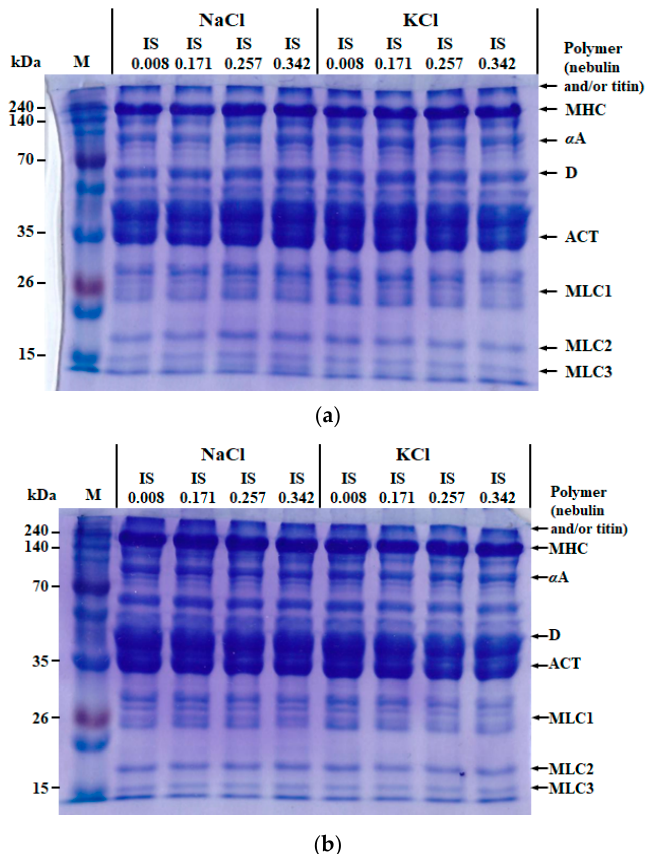
Figure 3. Representative sodium dodecyl sulfate poly-acrylamide gel electrophoresis (SDS-PAGE) photos of colloid Coomassie blue-stained 12.5% polyacrylamide gels of pre- ( a ) and post-rigor ( b ) salted chicken breast with NaCl or KCl at different ionic strengths. IS, ionic strength; M, standard protein marker; polymer, probably nebulin and/or titin; MHC, myosin heavy chain; α A, α -actinin; D, desmin; ACT, actin; MLC, myosin light chain.